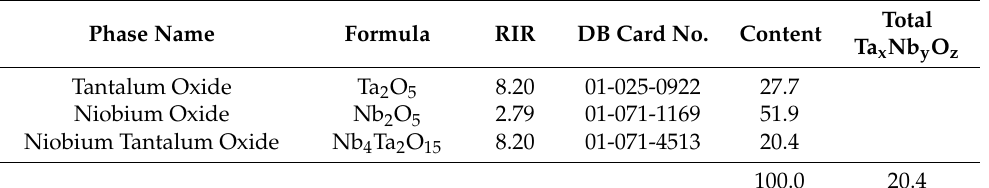
Table 3. Quantitative XRD (phase) analysis results (WPF, combined with RIR) of a 70 mol% Nb 2 O 5 to